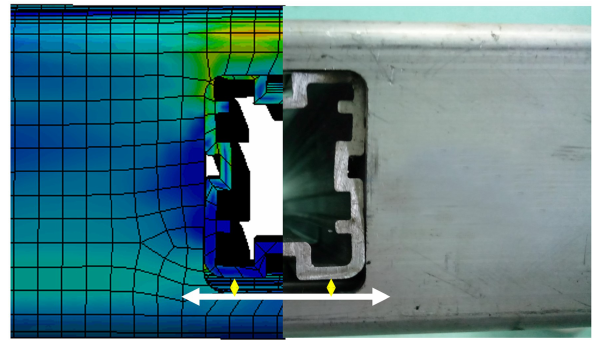
Figure 11: MT-T joints experimental deformation detail